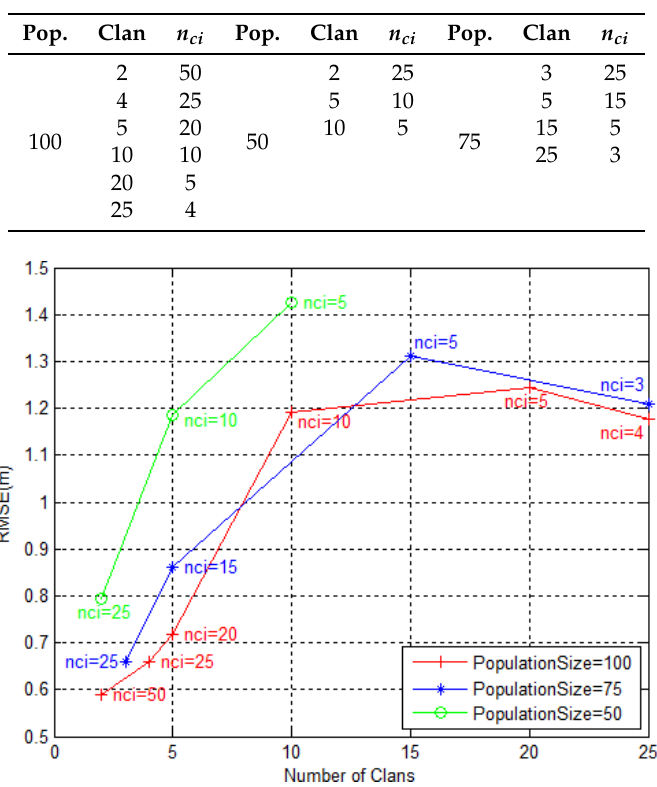
Table 1. The considered simulation setting for constant population size experiment.